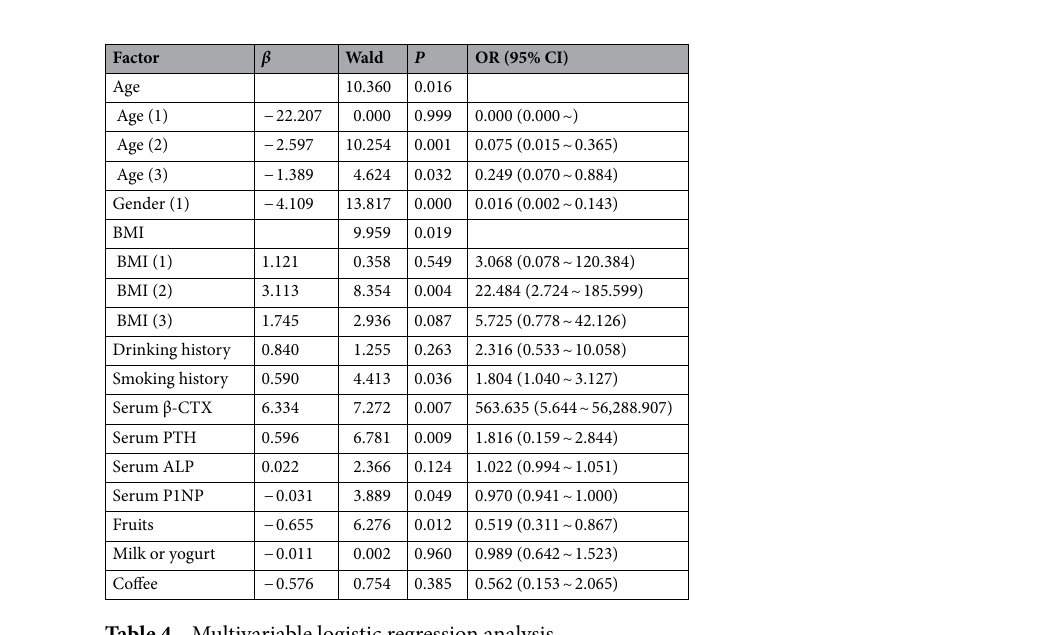
Figure 3. CG + OP and CG + non-OP groups diet types.